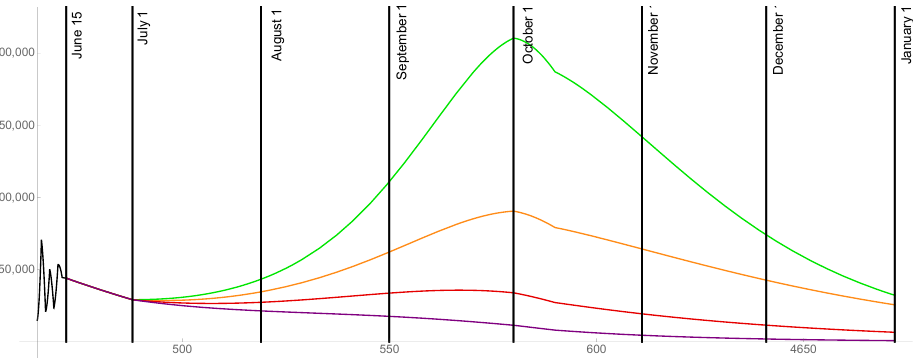
Figure 10. Transmission rates for the level of social distancing resumption ω = 0.03 (green), ω = 0.025 (orange), ω = 0.02 (red), ω = 0.015 (purple). The ultimate vaccinated population reaches 80%.